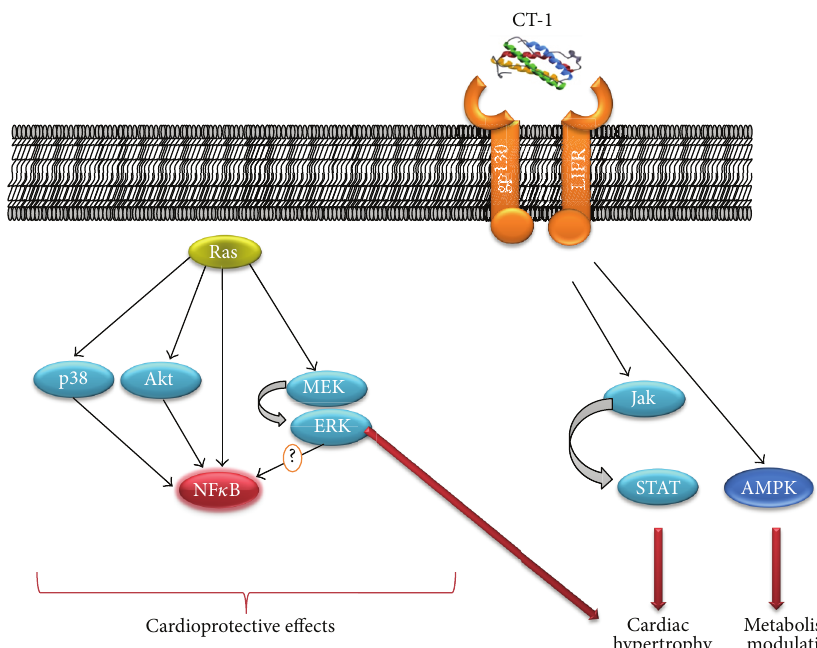
Figure 1: Activation of the Jak-Stat, MAP kinase signal transduction pathways, and AMPK, by CT-1 in cardiomyocytes. The mechanisms of Stat activation as well as a putative signaling cascade leading to NF 𝜅 B (nuclear factor-kappa B) activation are shown. Downstream target genes linking the Jak-Stat, MAP kinase signal transduction pathways, and AMPK to the induction of cardiomyocyte hypertrophy, antiapoptotic and metabolic effects of CT-1 remain to be